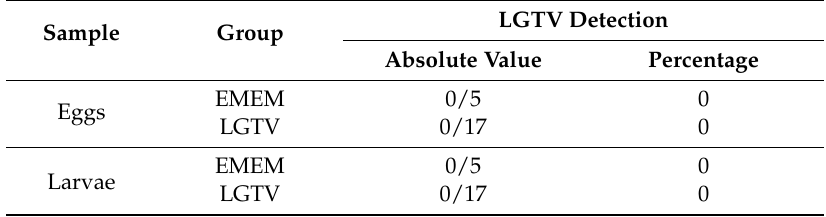
Table 5. Detection of Langat virus RNA in eggs and larvae using reverse transcription